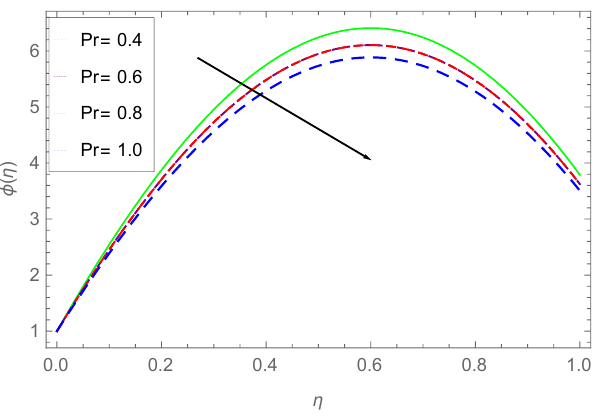
Figure 13. Impact of Pr on φ ( η ) , when Sc = 0.6, (cid:101) = 0.2, β = 0.6, S = 0.5, Nb = 0.6, Nt =